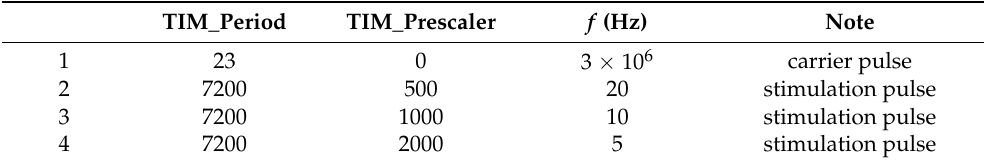
Table 3. The parameter design of the PWM